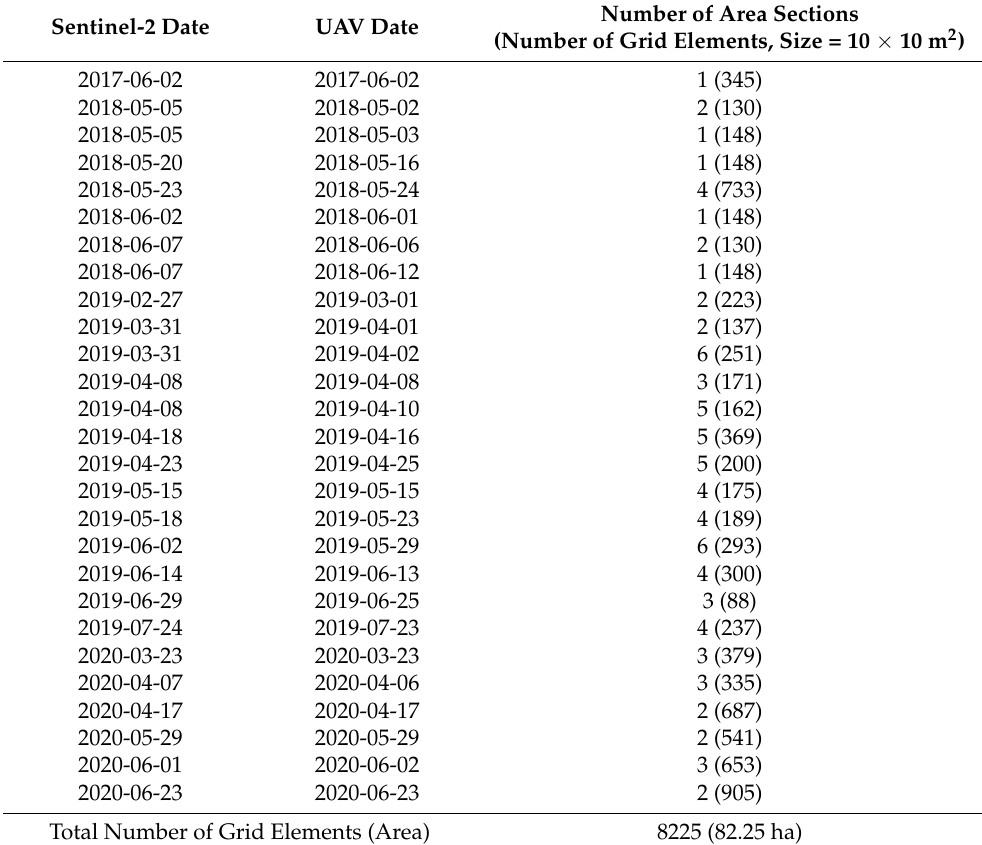
Table A2. Acquisition dates and data volume for the evaluation of the